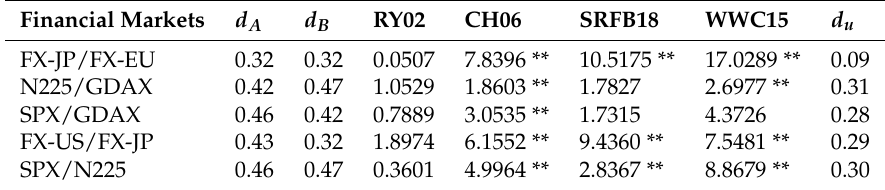
Table 10. Results for stationary fractional cointegration for the subsample